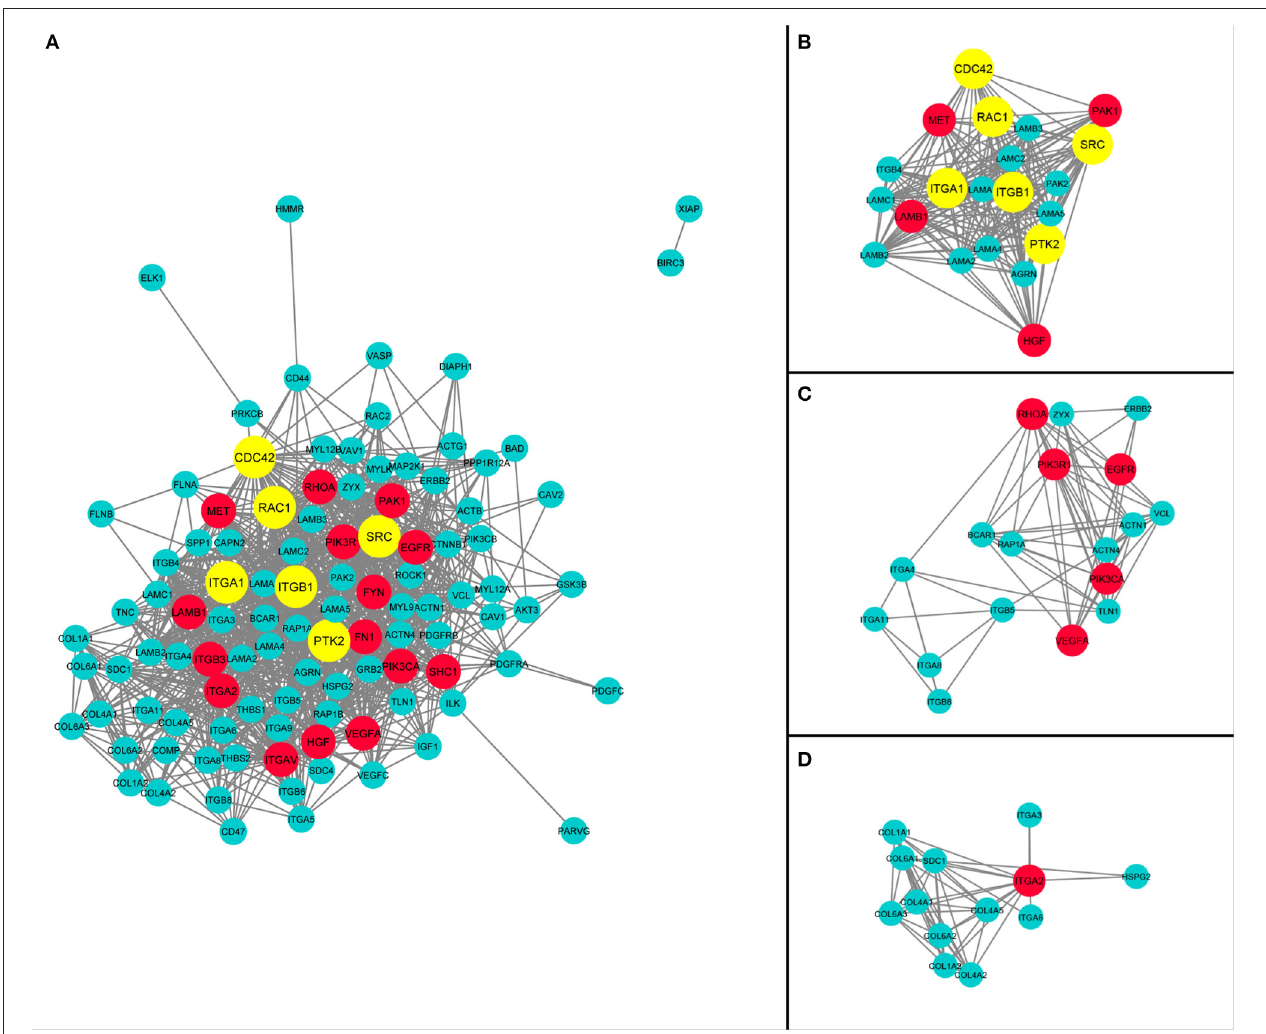
FIGURE 6 | Hub genes of pancreatic cancer (PaCa) and protein–protein interaction network of entities given in Figures 3 , 4 . (A) The network indicates significant interactions in PaCa pathways. Fourteen hub genes highlighted with having highest interaction degree. Six Hub genes identified by CytoHubba app of Cytoscape are highlighted with yellow color. (B) PPI network of PaCa specifying 10 hub genes with a cluster of highly interactive genes in the network. (C) PPI network of PaCa specifying 5 hub genes with a cluster of second highly interactive genes in the network. (D) The cluster of third highly interactive genes with 1 hub genes in the